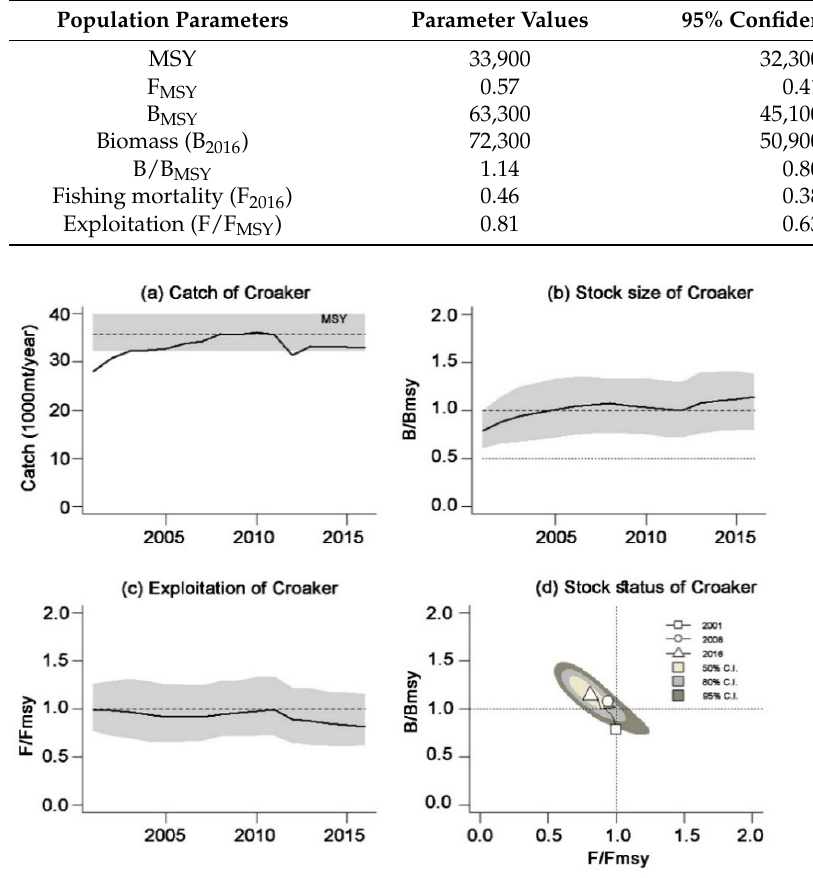
Figure 4. Schematic plots represent the result for croaker fishery in the BoB based on BSM analysis: ( a ) time series of catch and the estimated MSY with 95% confidence interval (CI) in gray area; ( b ) time series drive of relative biomass (B/B MSY ); ( c ) time series drive of exploitation (F/F MSY ); ( d ) relationship between F/F MSY and B/B MSY with CI of 50% (yellow), 80% (gray), and 95% (black). Table 4. Management information of croaker in the BoB produced by BSM method.